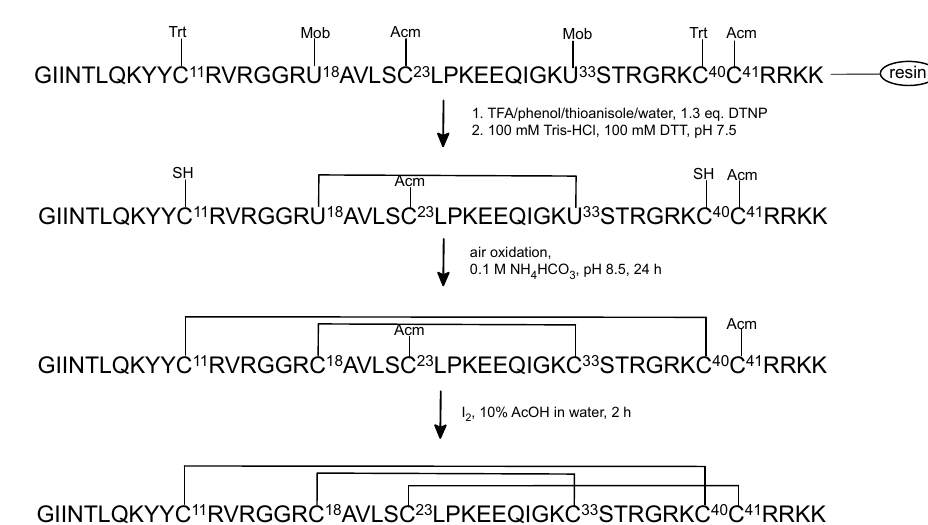
Figure 6. The scheme of oxidative folding conditions of [Sec 18,33 ]HBD ‐ 3.